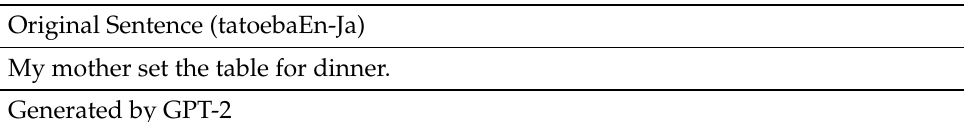
Table 2. An example of GPT-2 predicting the continuation of a sentence of tatoebaEn-Ja and WMT14En-De. In the case of the tatoeba corpus, a novel-like sentence is generated, while in the case of the WMT corpus, a news-like sentence is